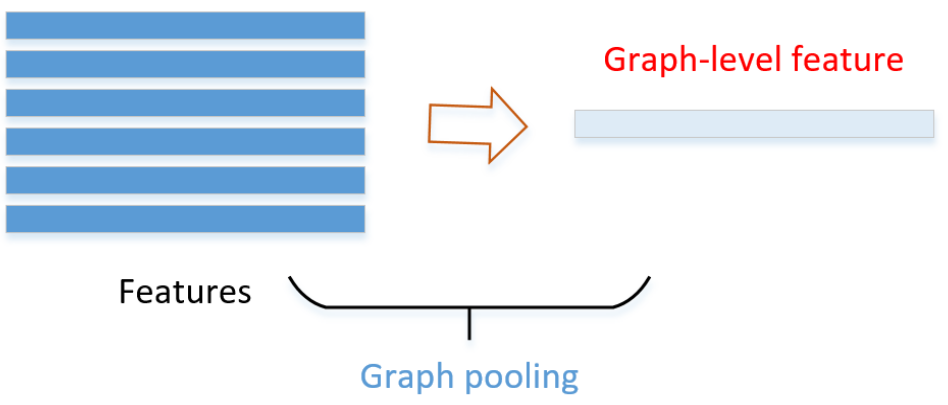
Figure 2. The illustration of graph